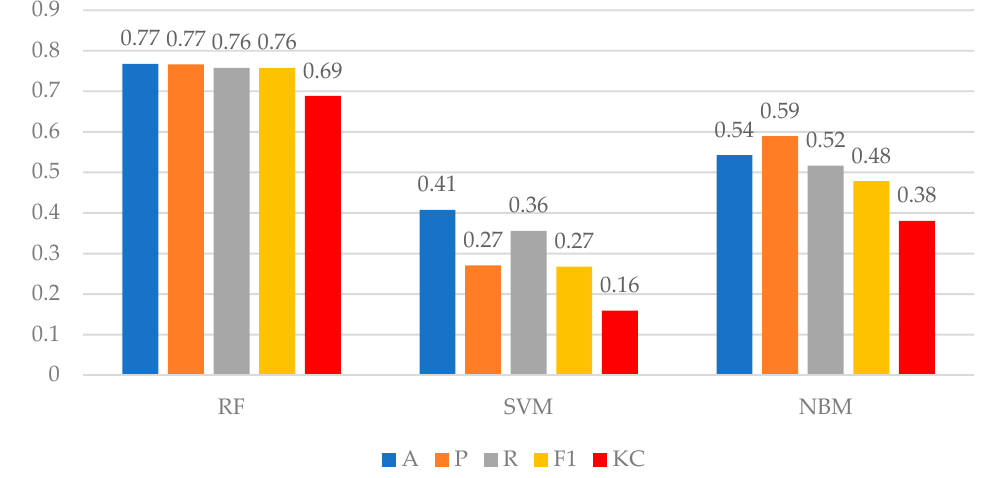
Figure 11. Comparison of five indicators between different models.